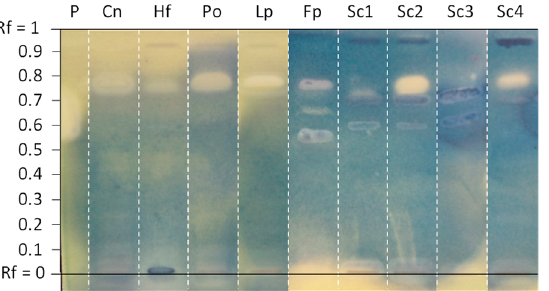
Figure 5. TLC bioautograms of polymyxin B (P) and EtOAc extracts (initials of mushroom species) against the MDR E. coli strain